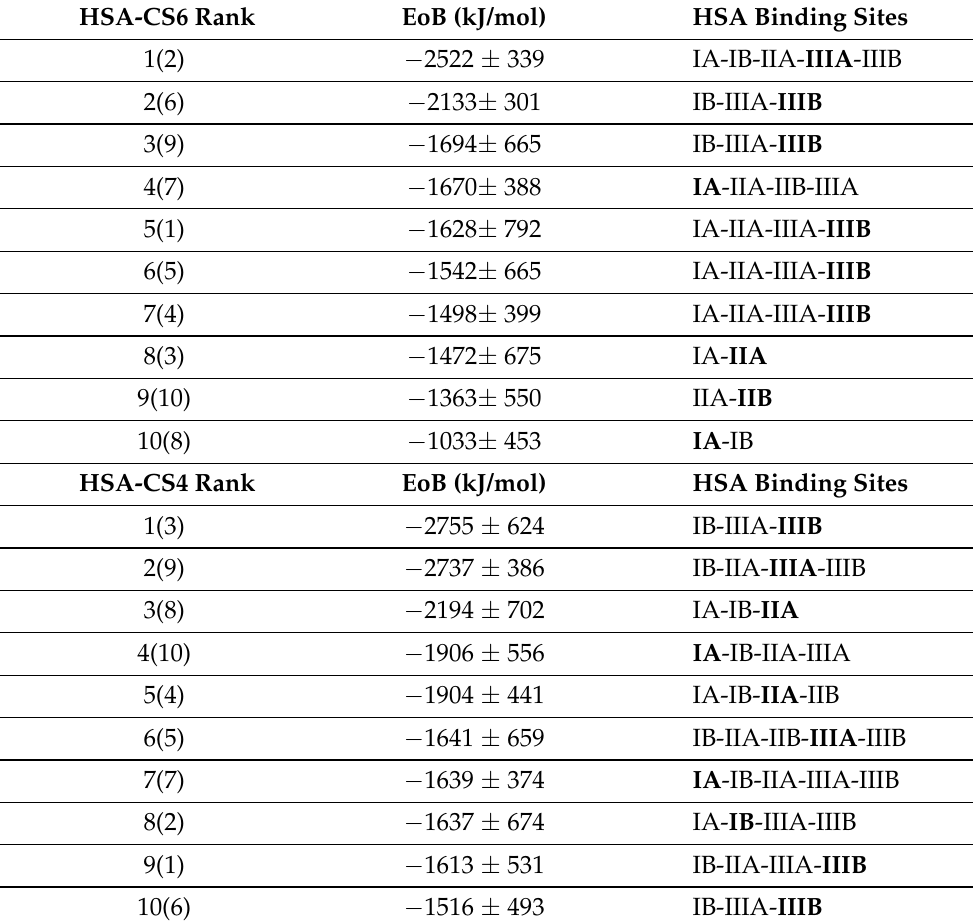
Figure 3. RMSD of backbone atoms of HSA:CS complexes as a function of time for the strongest bound complexes: ( a ) #2 for HSA:CS-6; and ( b ) #3 for HSA:CS-4 (cf., Table 1). Table 1. Binding ranks of HSA-CS6 (up) and HSA-CS4 (down) complexes. The first column contains two numbers: rank after MD simulations averaged over EoB, and in parenthesis, rank after docking (and before MD simulations). The second column provides values of EoB with STD, averaged over the part of the trajectory after equilibration (and for all ions). The strongest connected domains are marked with bold